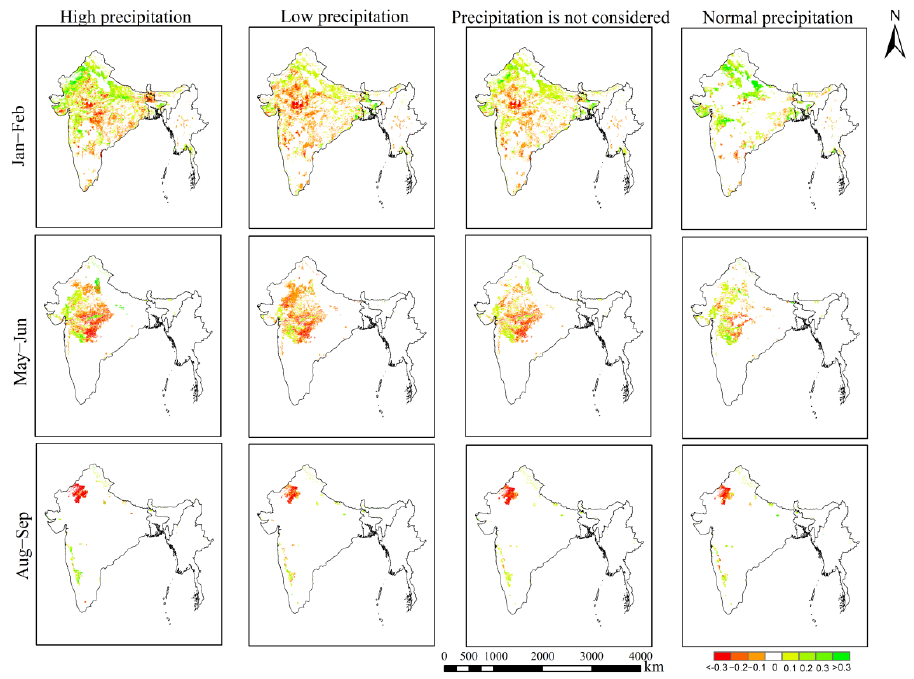
Figure 8. The degree of deviation of EVI between normal temperature with normal precipitation and different precipitation under extreme high temperature during growing seasons.